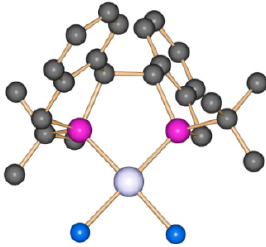
Figure 12. Molecular structure of the rhodium ammonia catalyst precursor [Rh(( S c, R p)-Duanphos)(NH 3 ) 2 ] + . Hydrogen atoms are omitted for clarity.